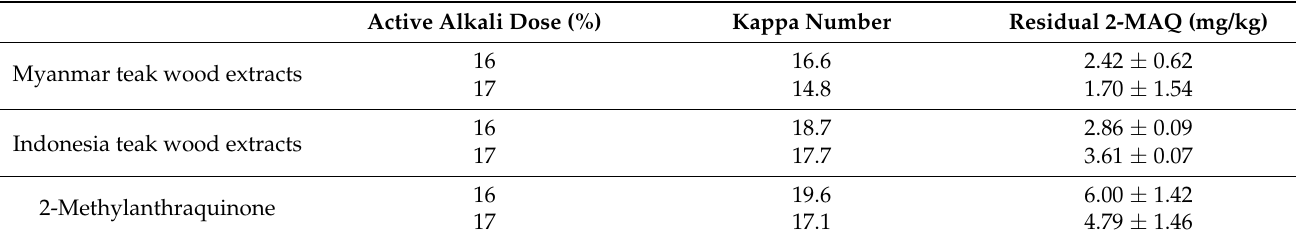
Table 4. Residual 2-methylanthraquinone (2-MAQ) contents in kraft